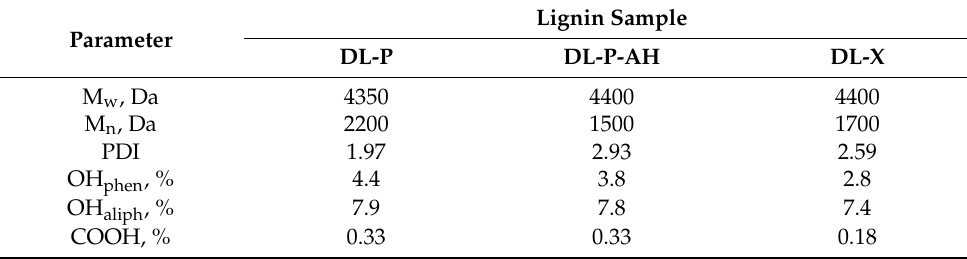
Table 2. Molecular weight characteristics and functional composition of the obtained lignin